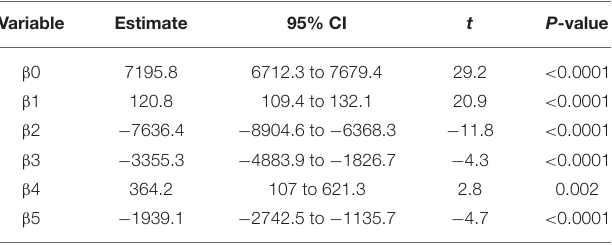
TABLE 2 | Results of linear regression for the interrupted time series analysis.